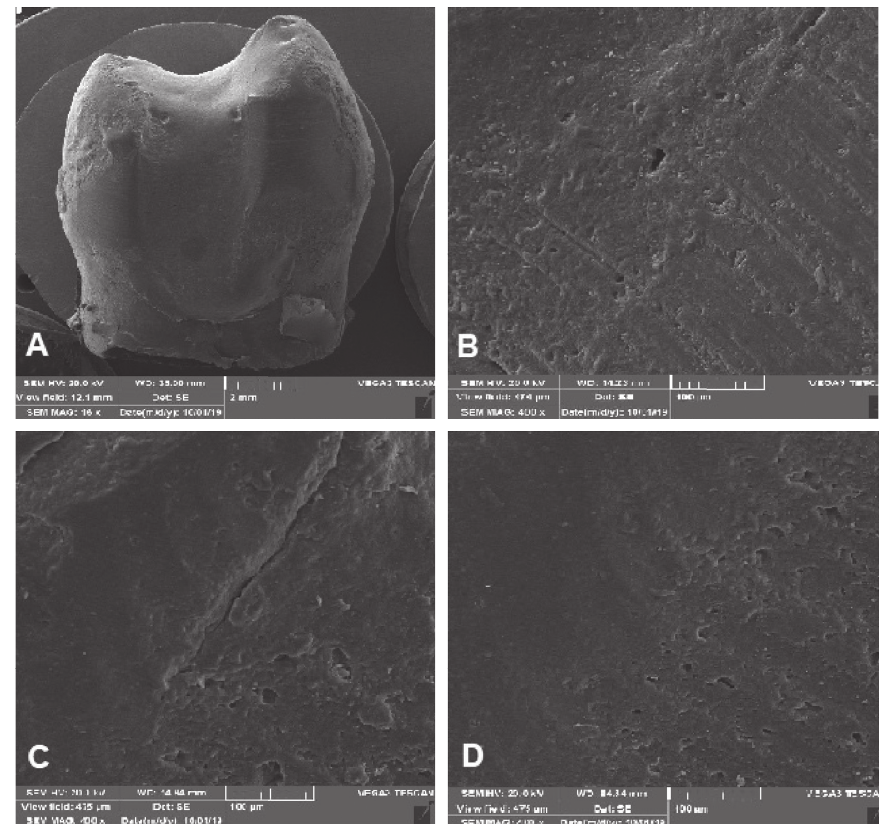
Figure 2: SEM images of the cavity-restoration interface at each gingival margin of the conservative restoration. (a) 16x, (b) 400x, (c) 400x, and (d) 400x.